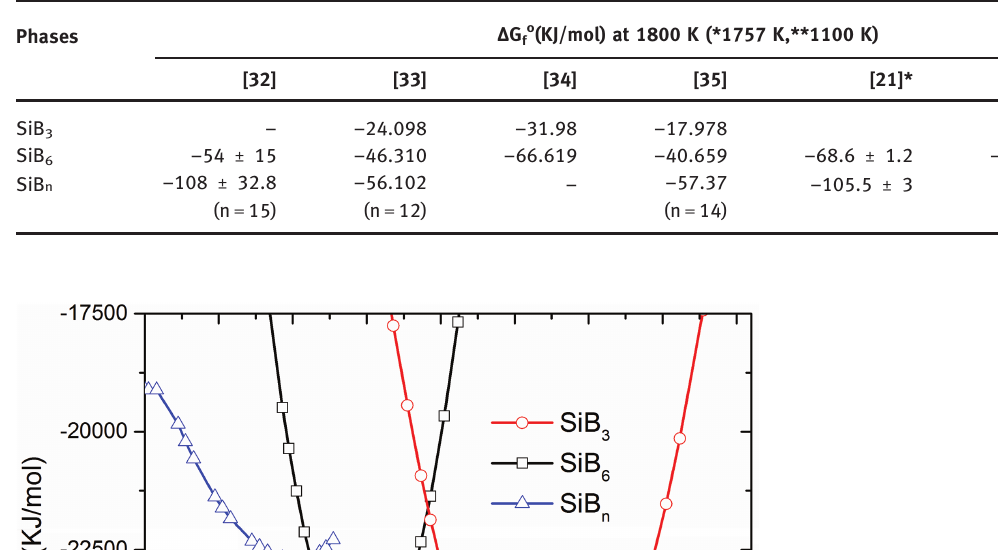
Table 2: Comparison of the thermodynamic properties of the Si-B system.